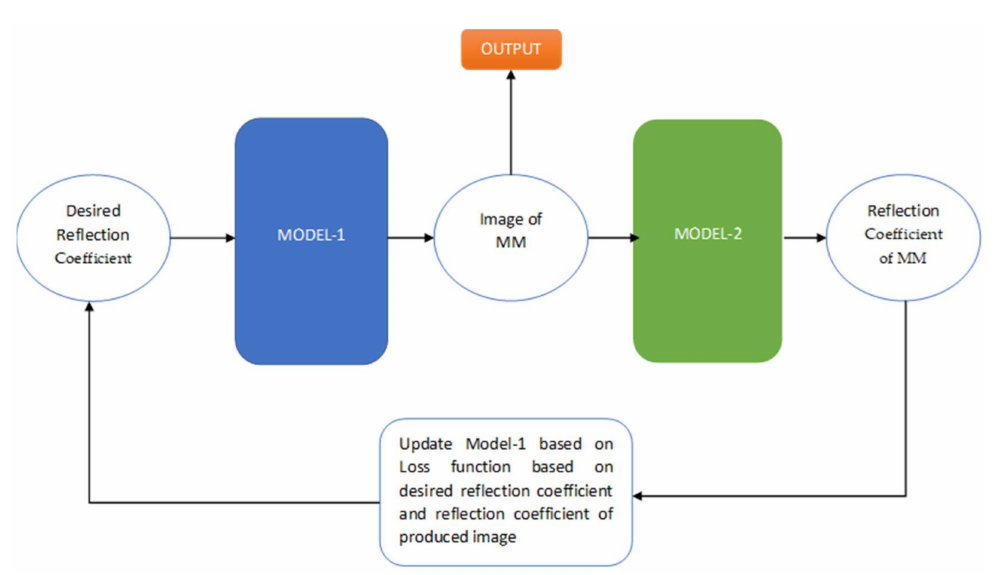
Figure 3. Schematic of the